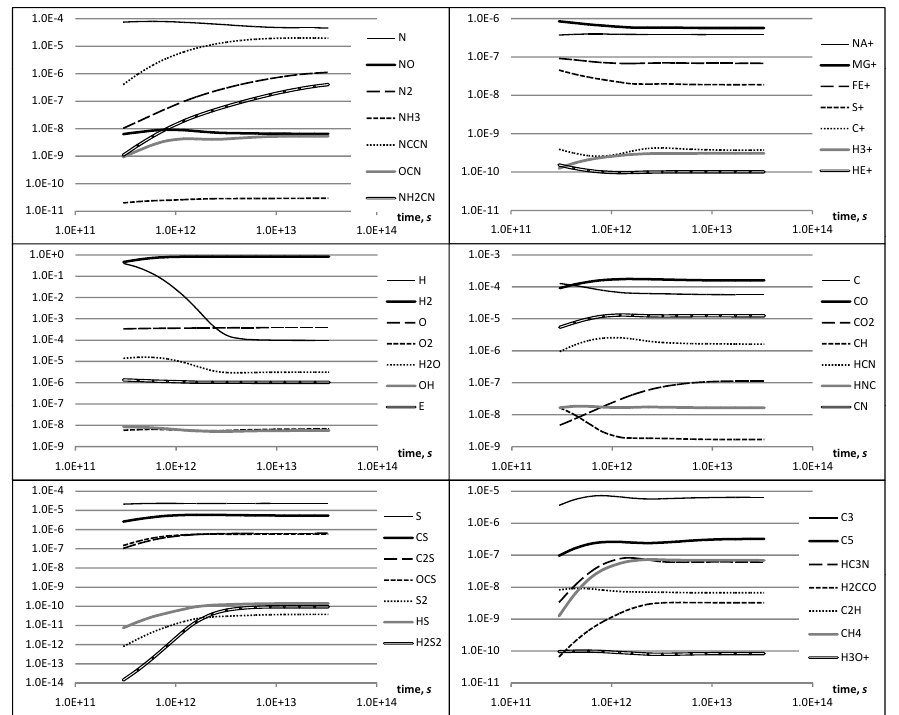
Fig. 1. Calculated gas-phase relative abundances for selected species for Model 1 (pure gas-phase). Pay attention to the relative abundance (ordinate) scale for each graph.